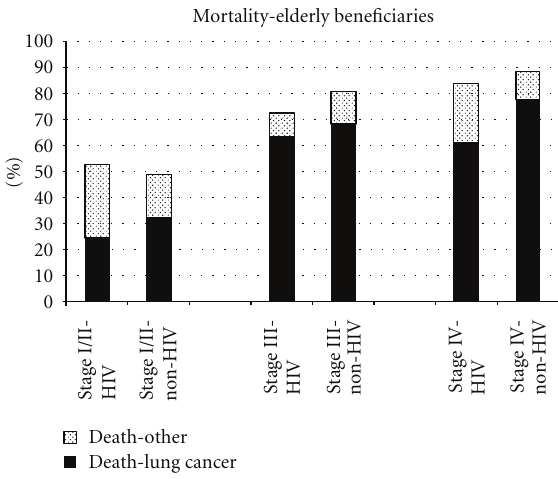
Figure 2: Mortality rate by stage of disease, HIV status, and cause from the SEER-Medicare database.